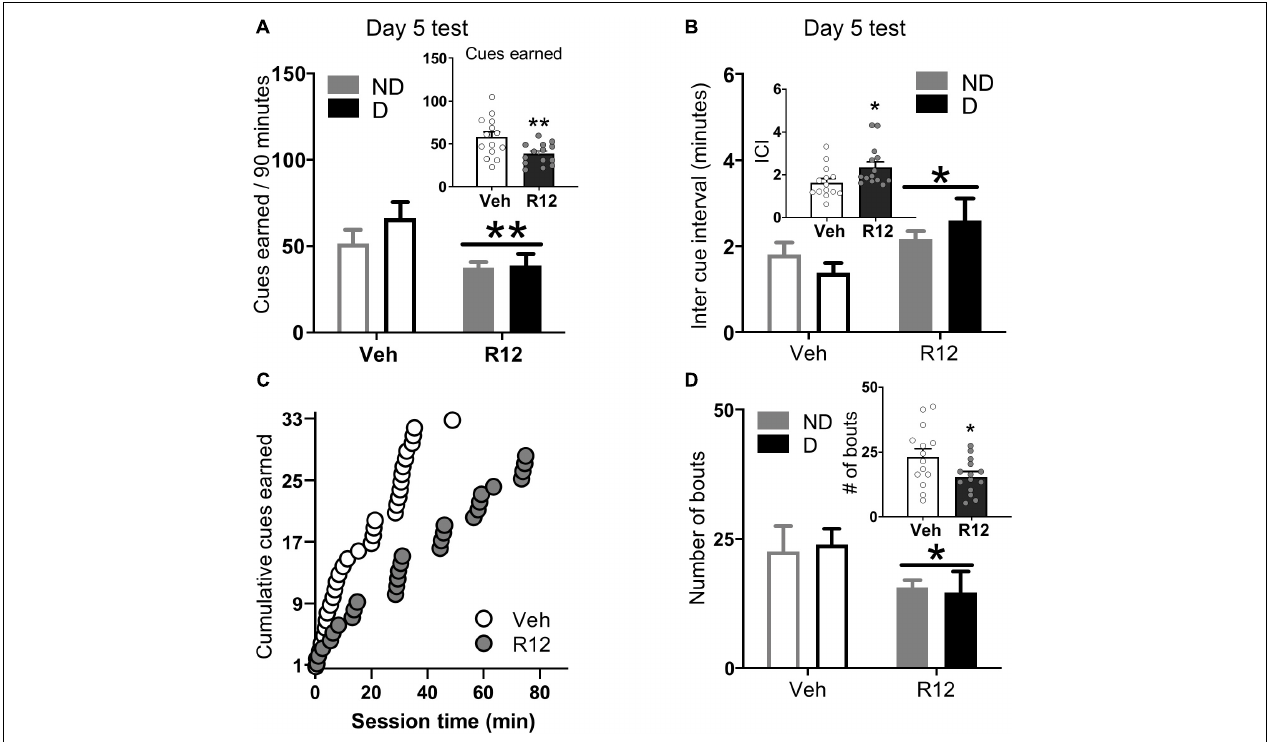
FIGURE 3 | Experiment 2: BNST CRFR1 antagonist effect on fentanyl seeking during acute withdrawal (Day 5) test. (A) Day 5 incubation test data showing cues earned on FR1, 20 s to schedule. (B) Inter cue interval (ICI), the time between presses that result in cues. (C) Cumulative cues earned pattern of a representative pair of vehicle ( ¯ X = 1.52) and R121919 ( ¯ X = 2.75) injected rat. (D) Number of bouts. A bout is defined as two or more presses for which the interval between successive presses did not exceed 20 s. * p < 0.05, ** p < 0.01, main effect of treatment. All the inset graphs indicate mean ± SEM when collapsed across dependence. ND, non-dependent; D, dependent. Data are mean ±